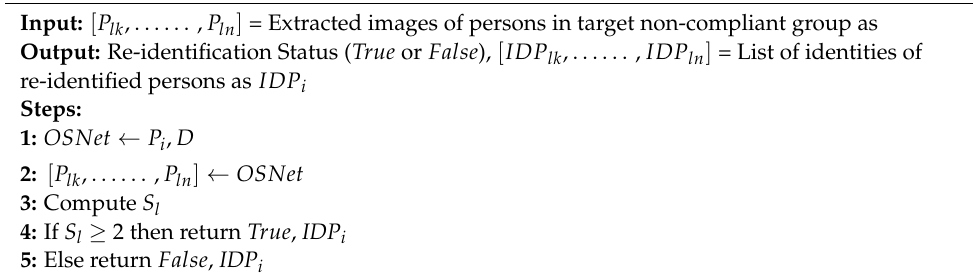
Algorithm 1 Re-identification of non-compliant